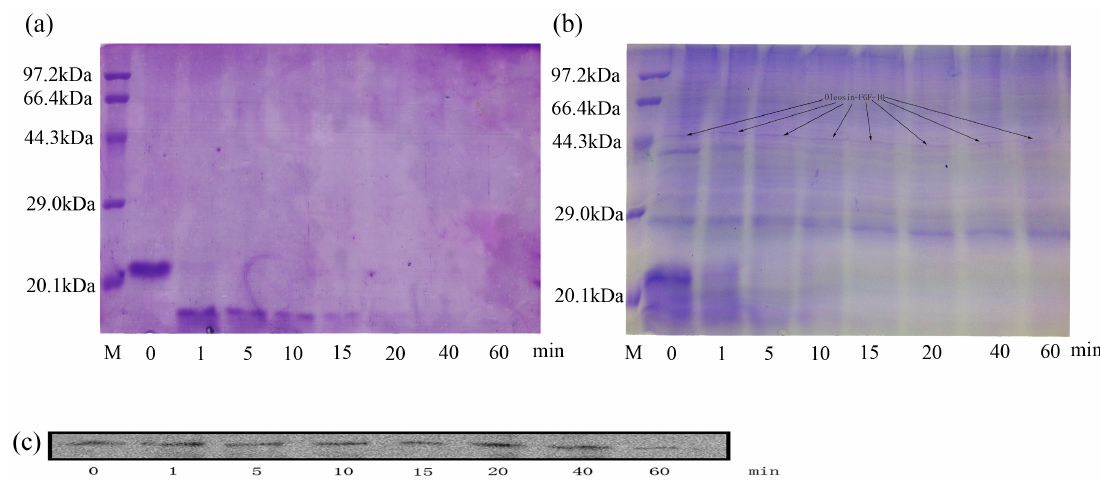
12 of 18 Figure 10. The number of regenerating hair follicles and expressing cytokeratin-14 were quantified. ( a ) Presenting the number of hair follicles; ( b ) the relative content ofcytokeratin-14. *** p < 0.001, ** p < 0.05.